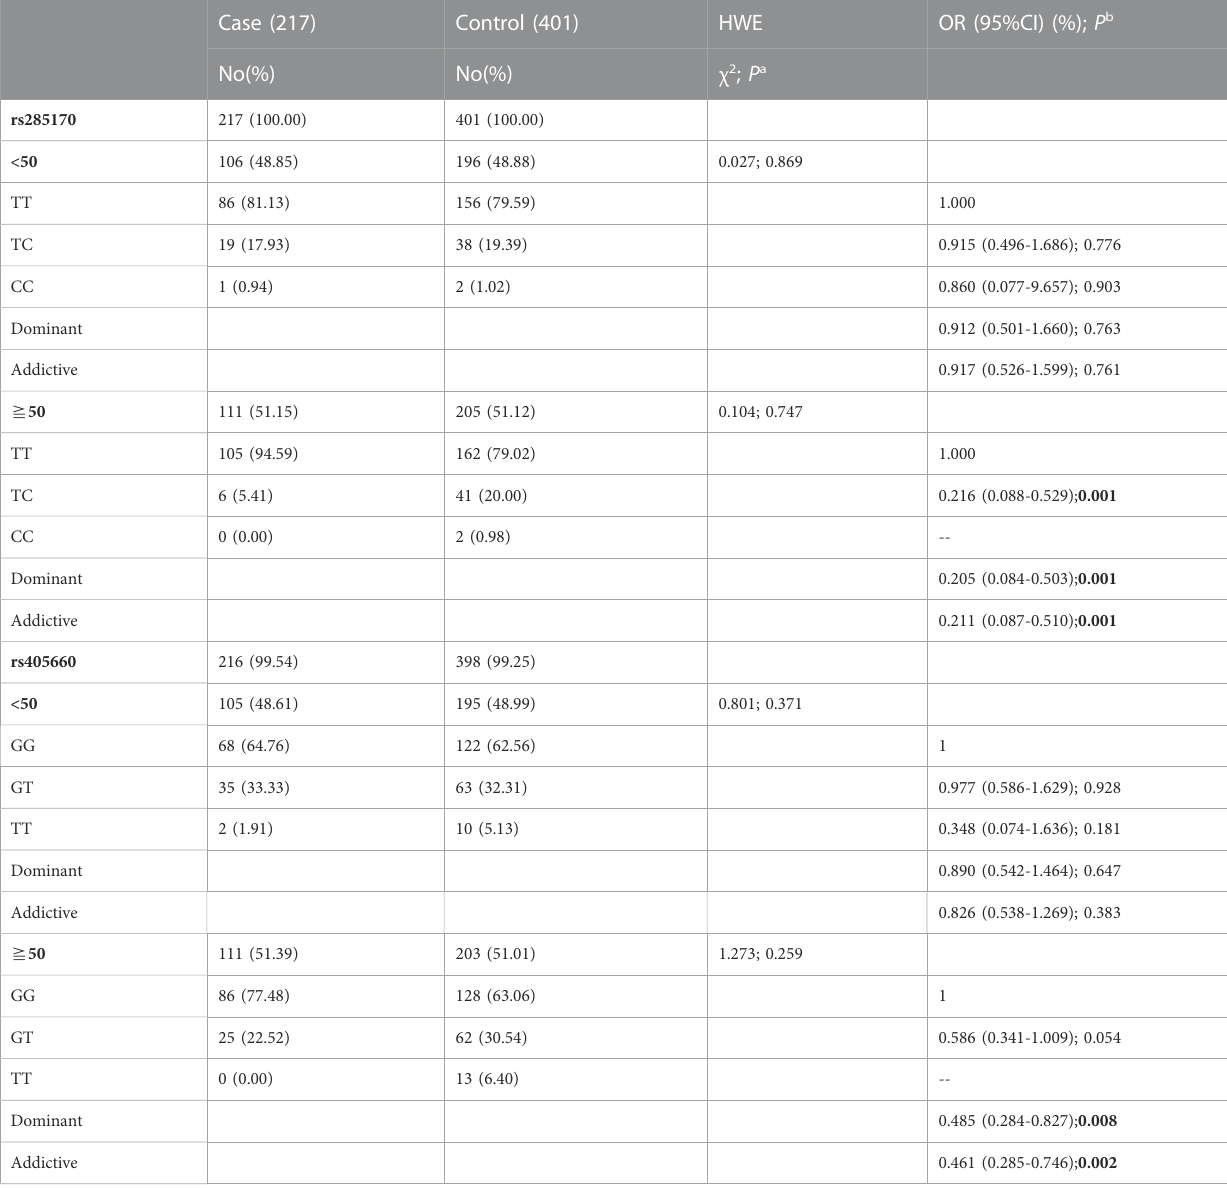
TABLE 4 Strati fi cation analysis of AS-related genetic variants and